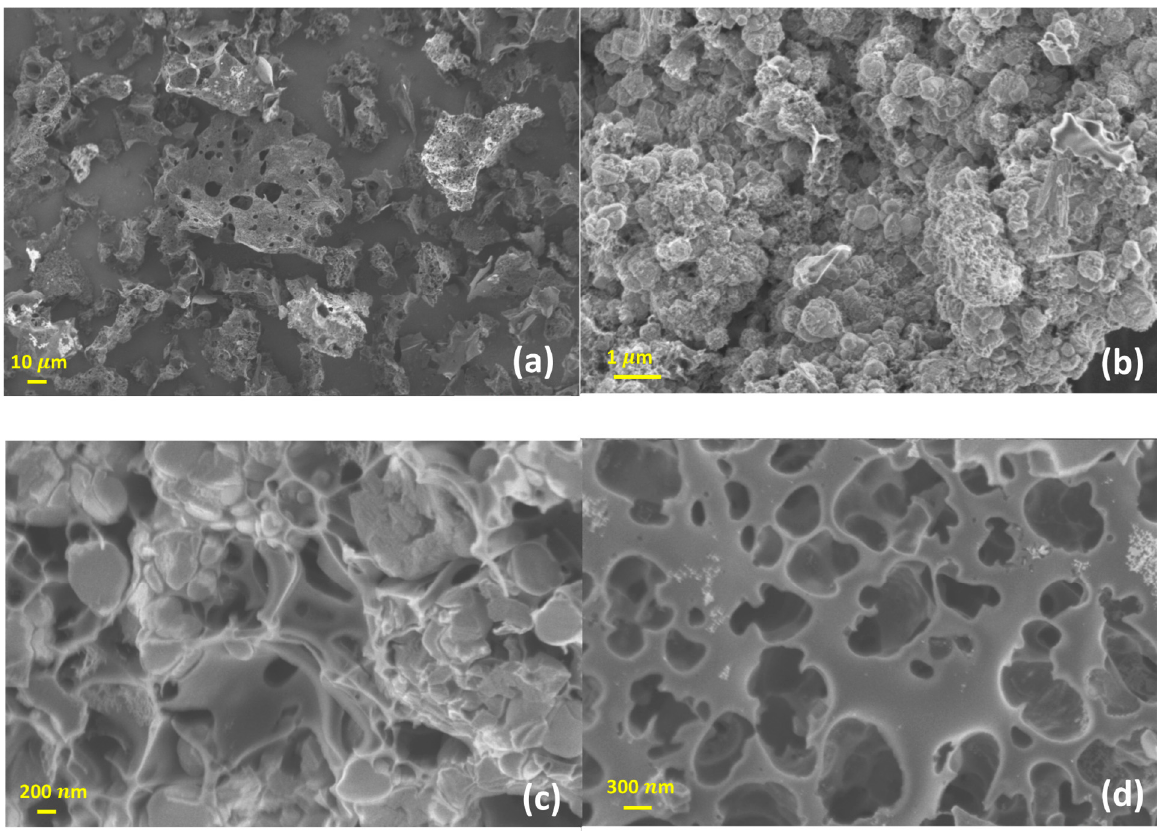
Figure 4. Representative Scanning Electron Imaging (SEM) results of LS-3 ( a – d ).